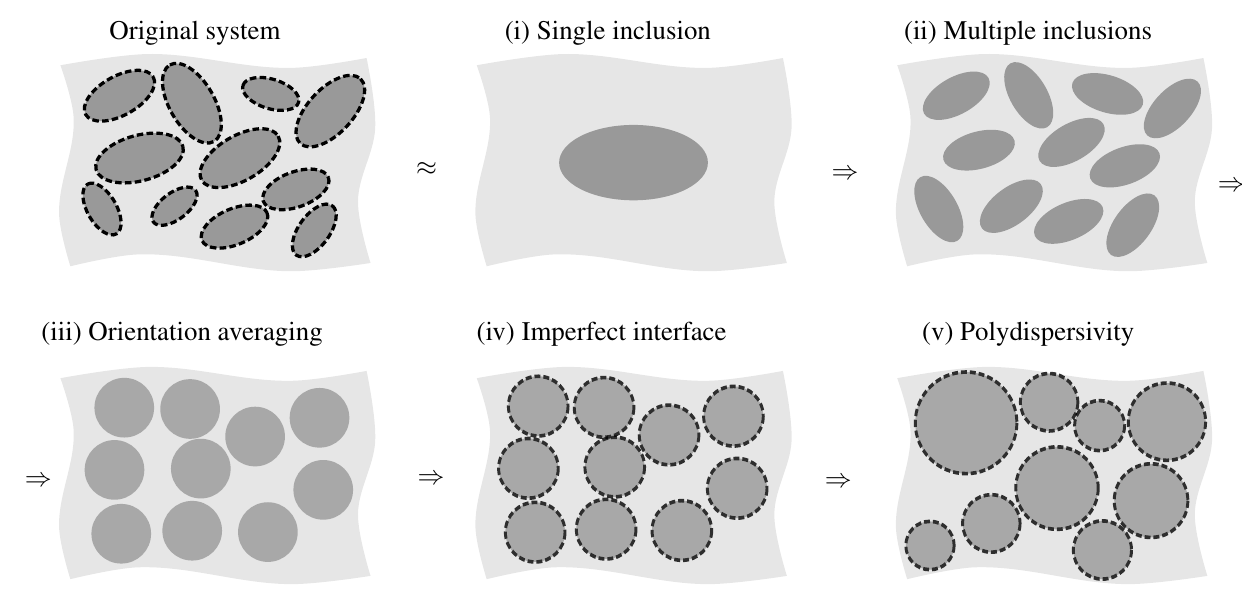
Figure 3. Mori-Tanaka based scheme: Strategy of